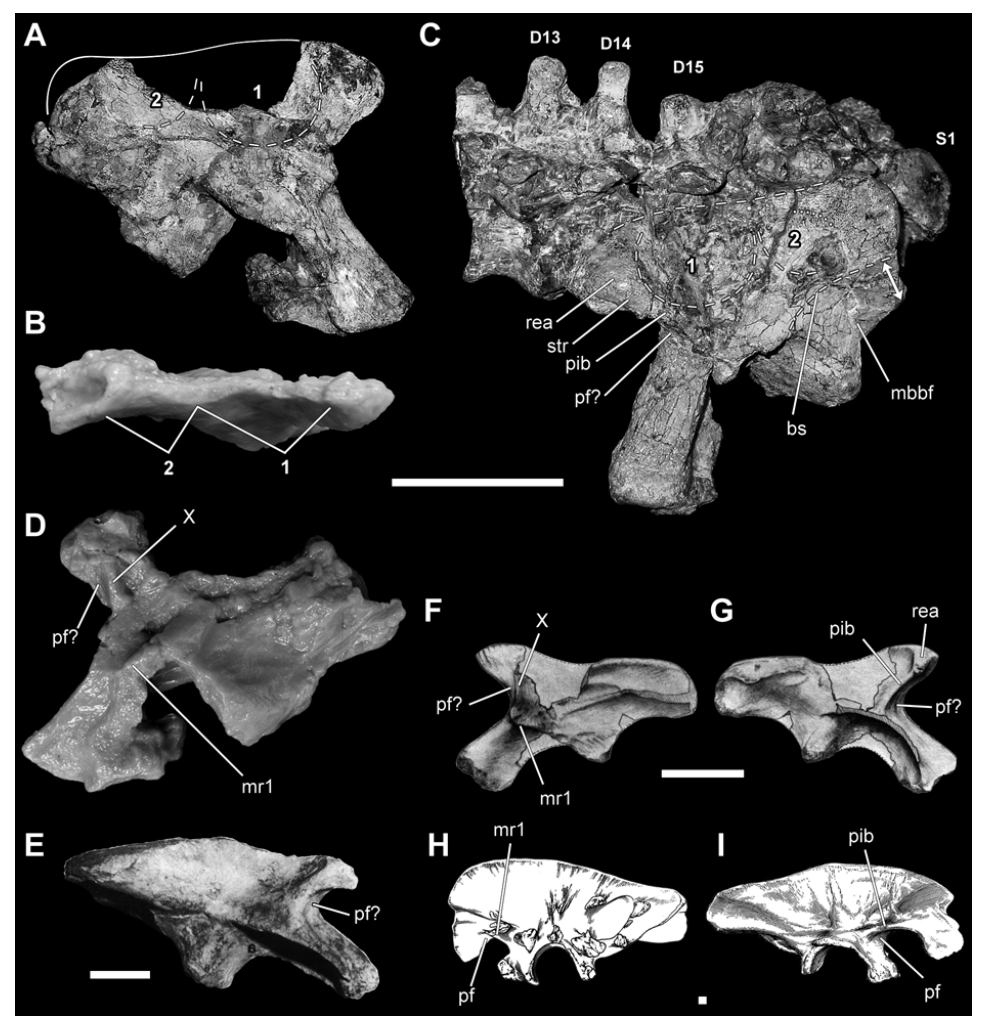
Fig. 4 – Right (A-B) and left (C) ilium of Staurikosaurus in lateral (A, C) and dorsal (B) views indicating the existence of two concavities (1 and 2) on the lateral surface and the expansion of the posterior part of the medial blade of the brevis fossa ( mbbf ), indicated by the two directions arrow (C). The dorsoposterior limit of ILFB origin (concavity 2) is indicated by a smooth border (dotted line in C). Right ilium of several taxa (D-I) indicating the presence of a preacetabular fossa ( pf ) or a similar structure ( pf ?) on the ventral surface of the cranial iliac process: Staurikosaurus (medial view [D]), Sellosaurus (lateral view [E]), Caseosaurus (medial [F] and lateral [G] views) and Tyrannosaurus (medial [H] and lateral [I] views). The first medial iliac ridge ( mr1 ) delimits the preacetabular fossa medially in Tyrannosaurus . In Staurikosaurus and Caseosaurus , this fossa is delimited medially by a border ( X ) connected, but not equivalent to the mr1 . Scale bars: 50 mm (E – from Galton 1984; F-G – from Long and Murry 1995; H-I – from Osborn